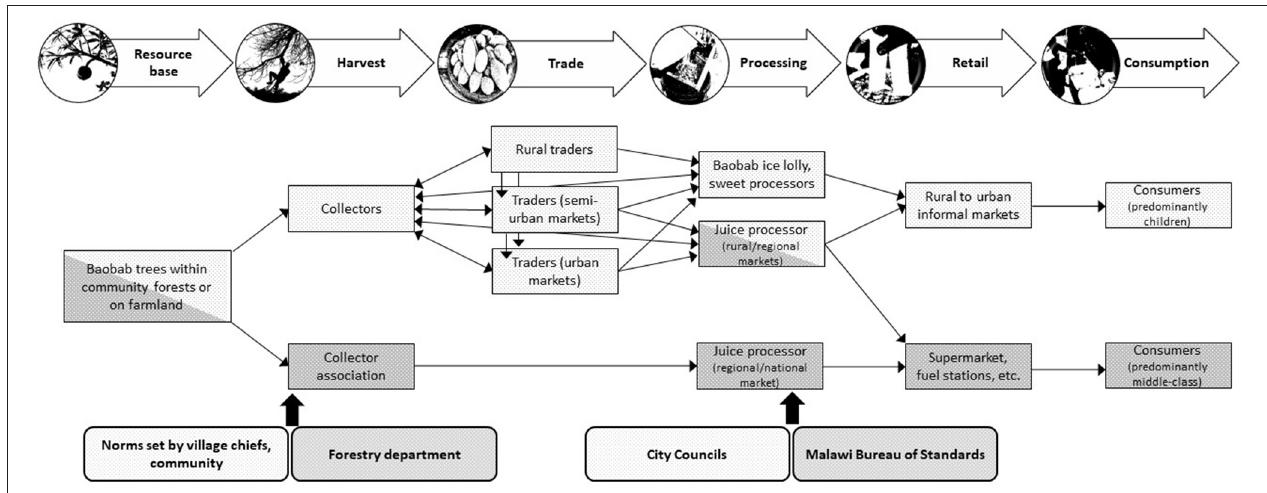
FIGURE 2 | Main stakeholders and channels in the Adansonia digitata L. value chain from Malawi. The dominant informal commercialization pathway is depicted in a lighter shade, the newly formed formal commercialization pathways in a darker